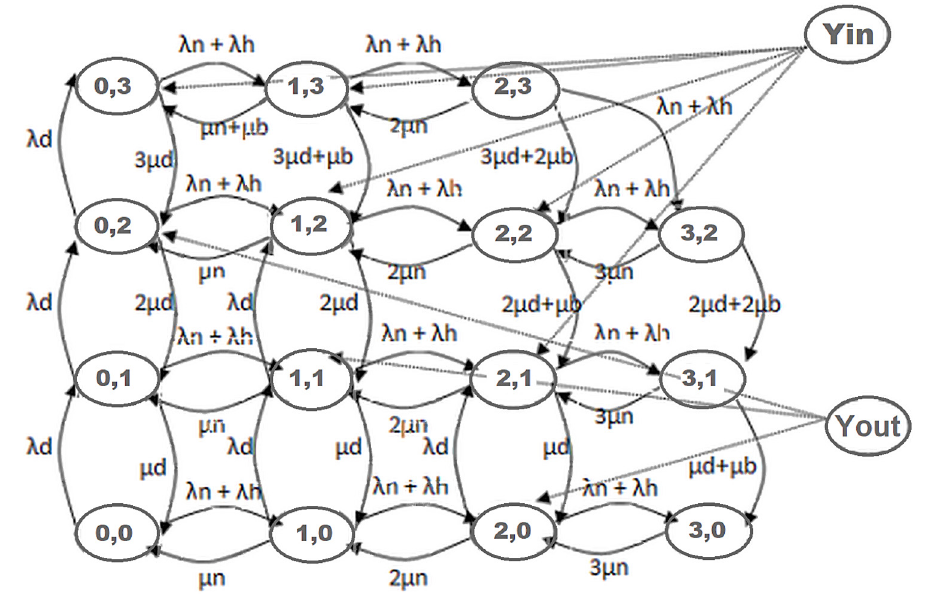
Figure 3. The state diagram with queue to calculate T yout / ( i , j )